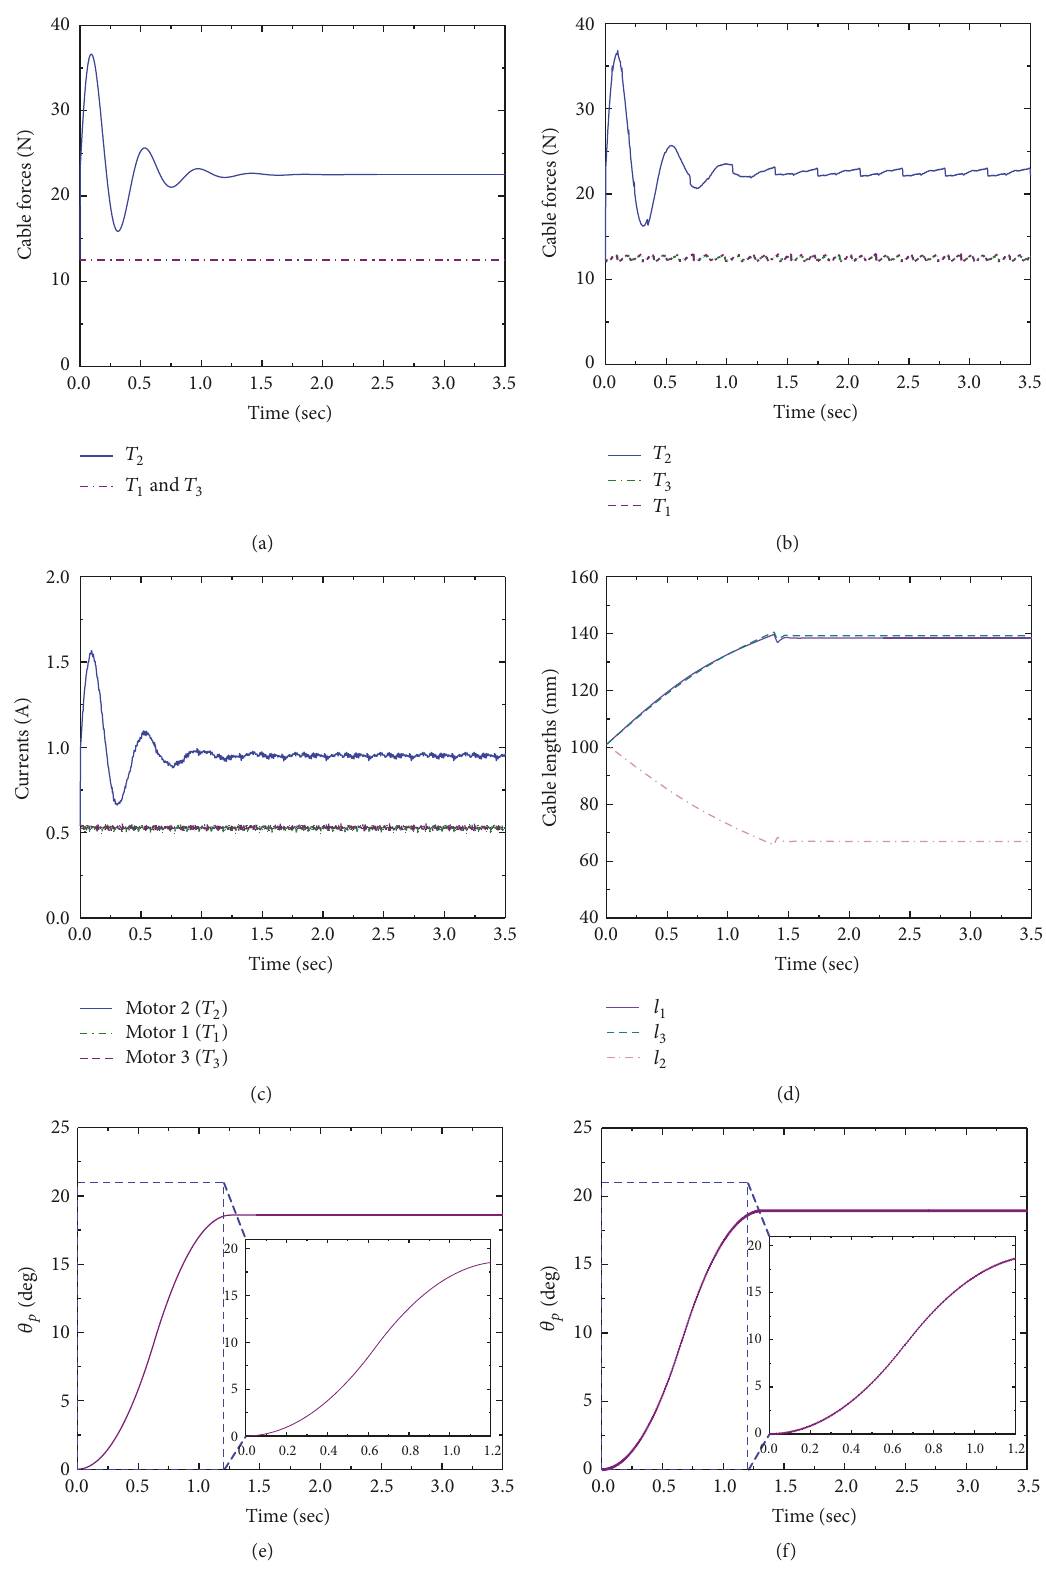
Figure 10: Responses of the system under closed-loop: (a) theoretical results of all cable forces under closed-loop, (b) experimental results of all cable forces under closed-loop, (c) experimental results of all motor armature currents under closed-loop, (d) experimental results of all cable lengths under closed-loop, (e) theoretical result of 𝜃 𝑝 under closed-loop, and (f) experimental result of 𝜃 𝑝 under